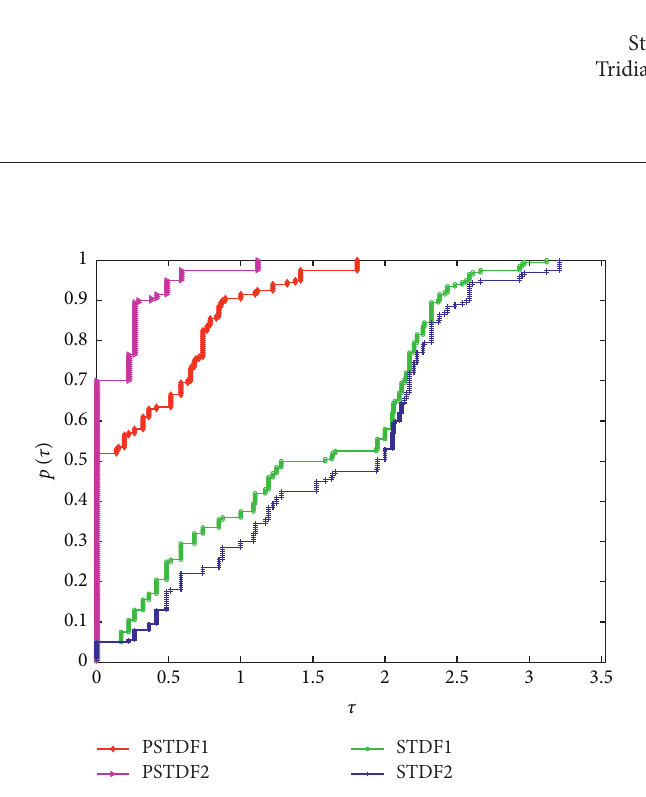
Figure 1: Performance profiles for the number of iterations